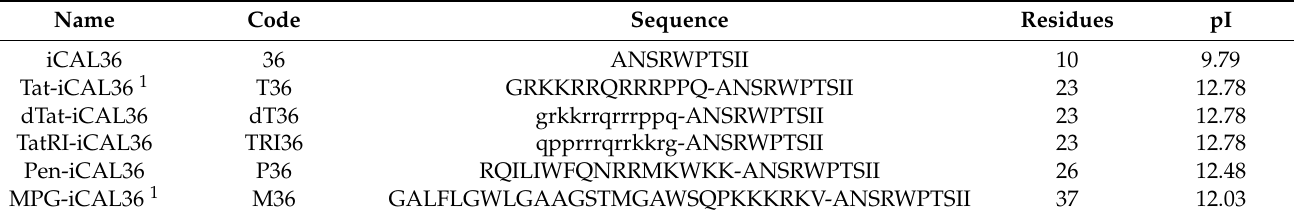
Table 1. Peptide sequences used in this